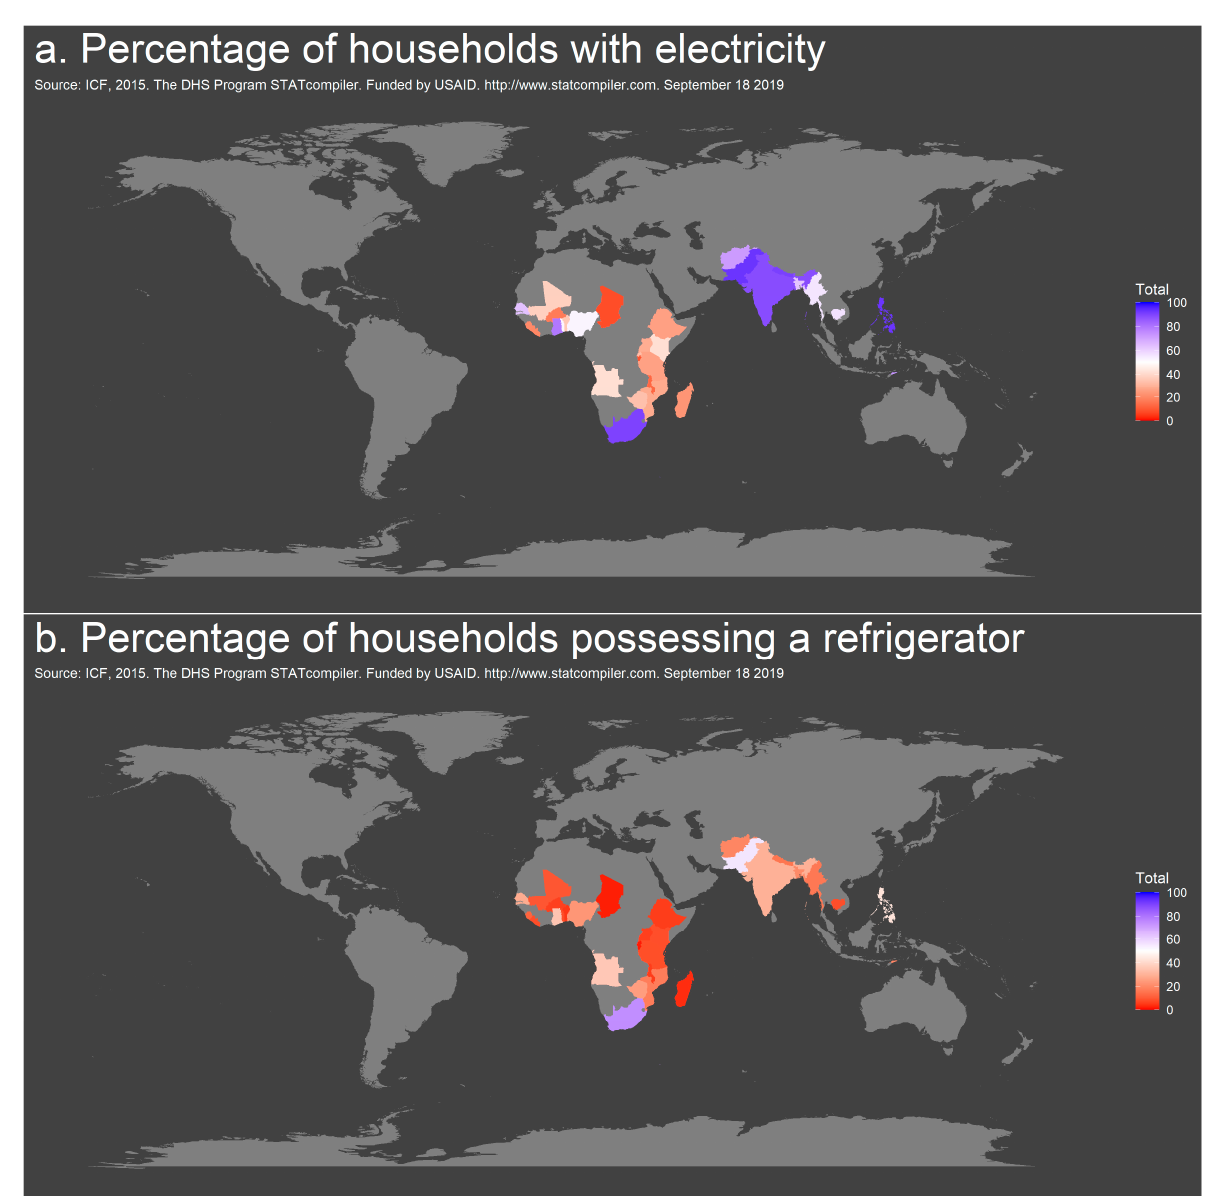
Figure 4. Geographic distribution of access to electricity ( a ) and refrigeration ( b ) in countries of Sub-Saharan Africa and Southeast Asia, 2014–2018.